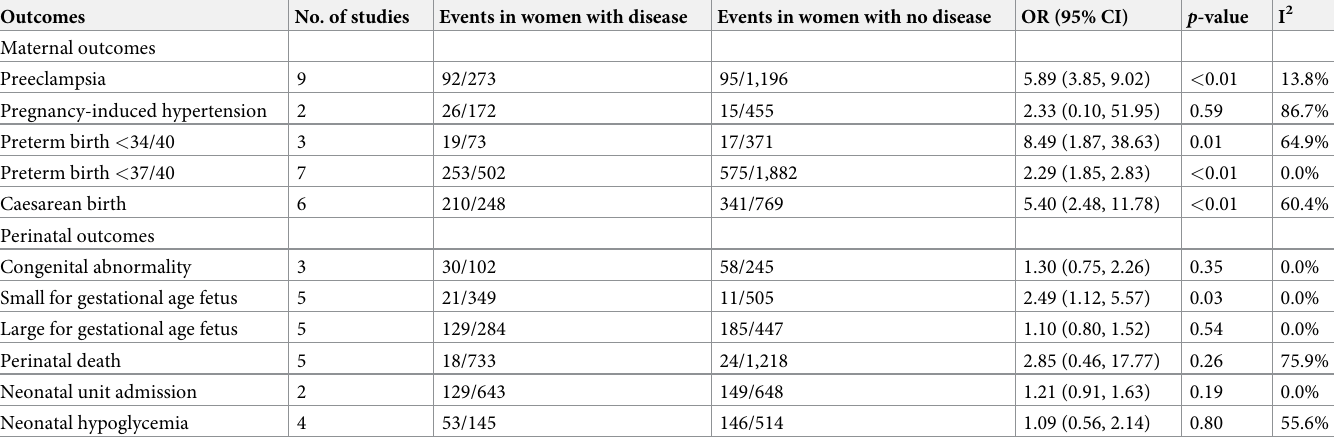
Table 1. Association between diabetic nephropathy and/or retinopathy and adverse maternal and perinatal outcomes. Outcomes No. of studies Events in women with